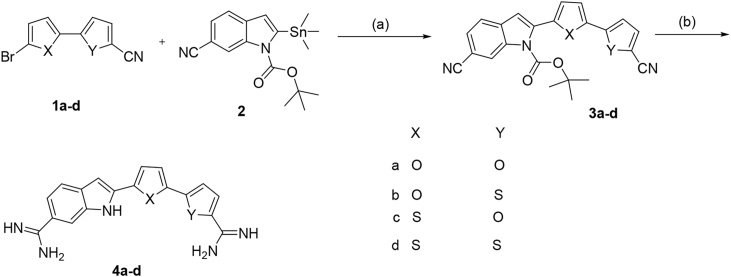
Reagenta and conditions: (a) Pd(PPh3), dioxane; (b) i-LiN(TMS)2/THF, ii-HCl gas/EtOH.